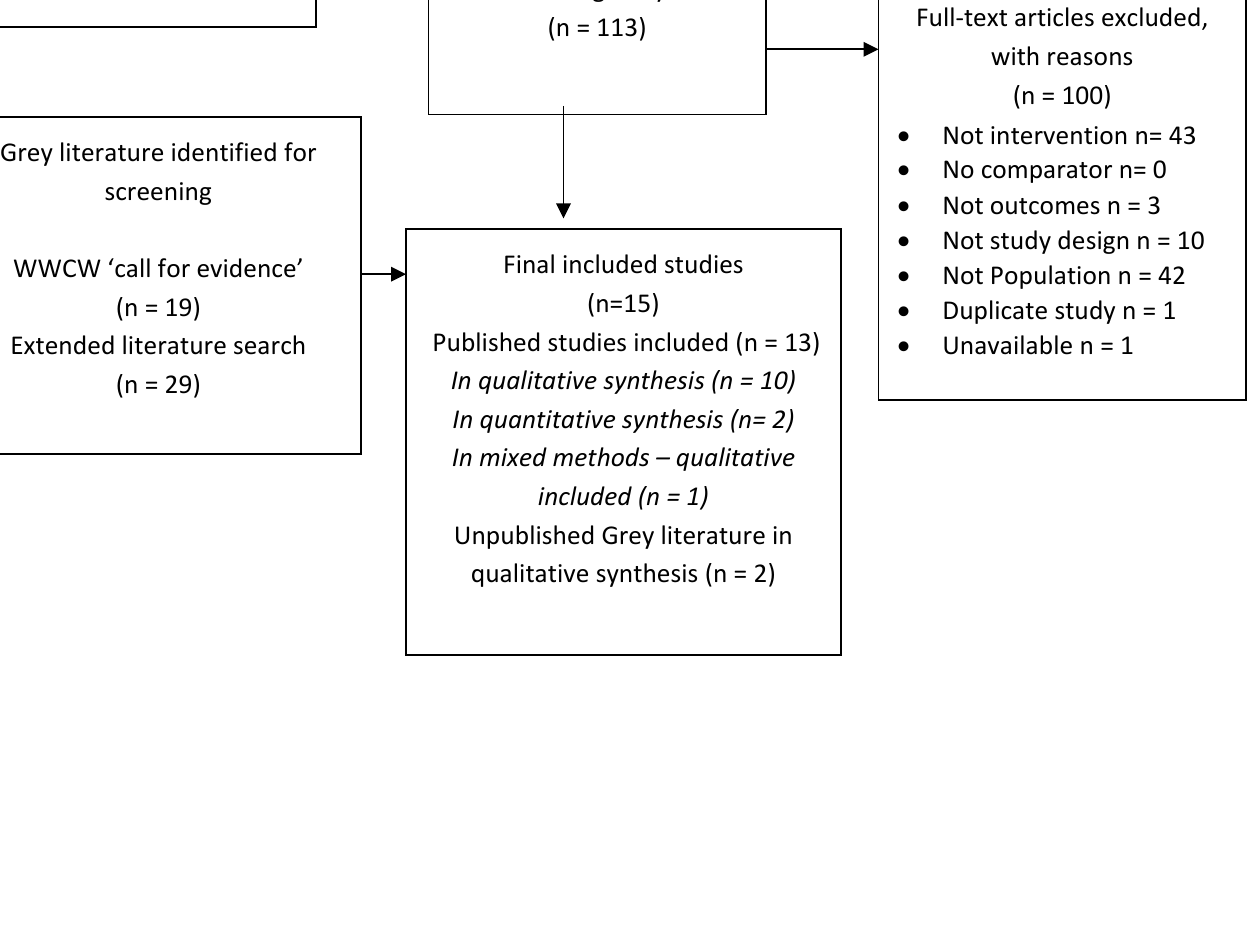
Records identified